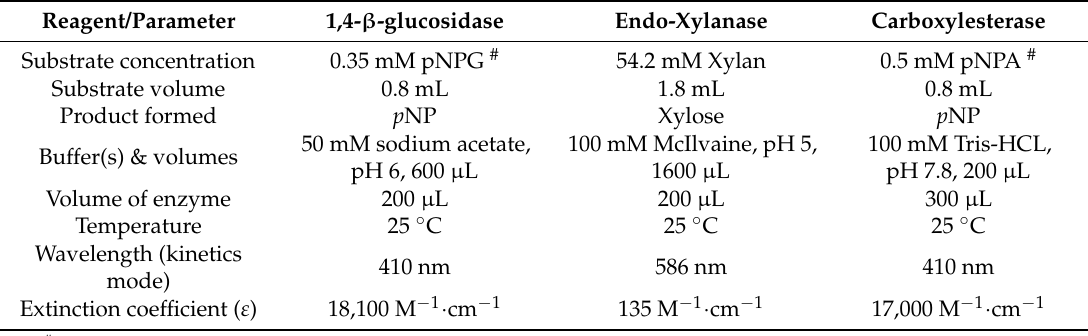
Table 2. Enzyme activity assays, reagents and conditions for N. mirabilis digestive